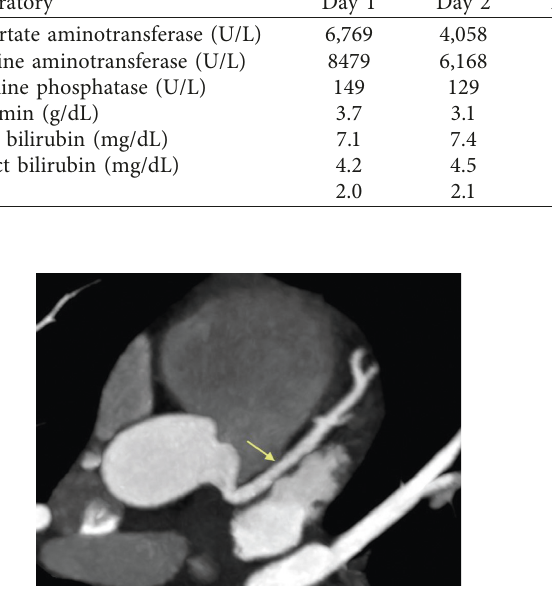
Figure 4: Coronary CT angiogram image revealing normally positioned left anterior descending artery (LAD) without any evidence of coronary artery disease.